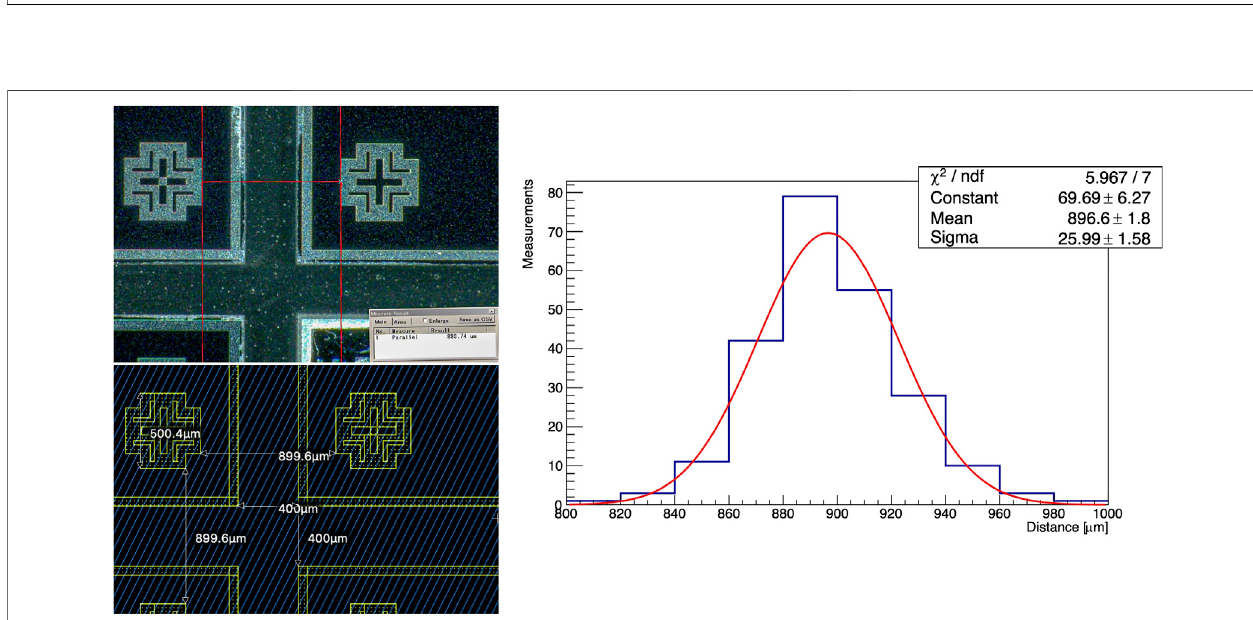
FIGURE 6 | (A) 3D reconstruction and (B) 2D map of the surface of wafer six reconstructed combining eight pro fi les along X axis. The surface has been straightened up by subtracting a plane, previously fi tted.